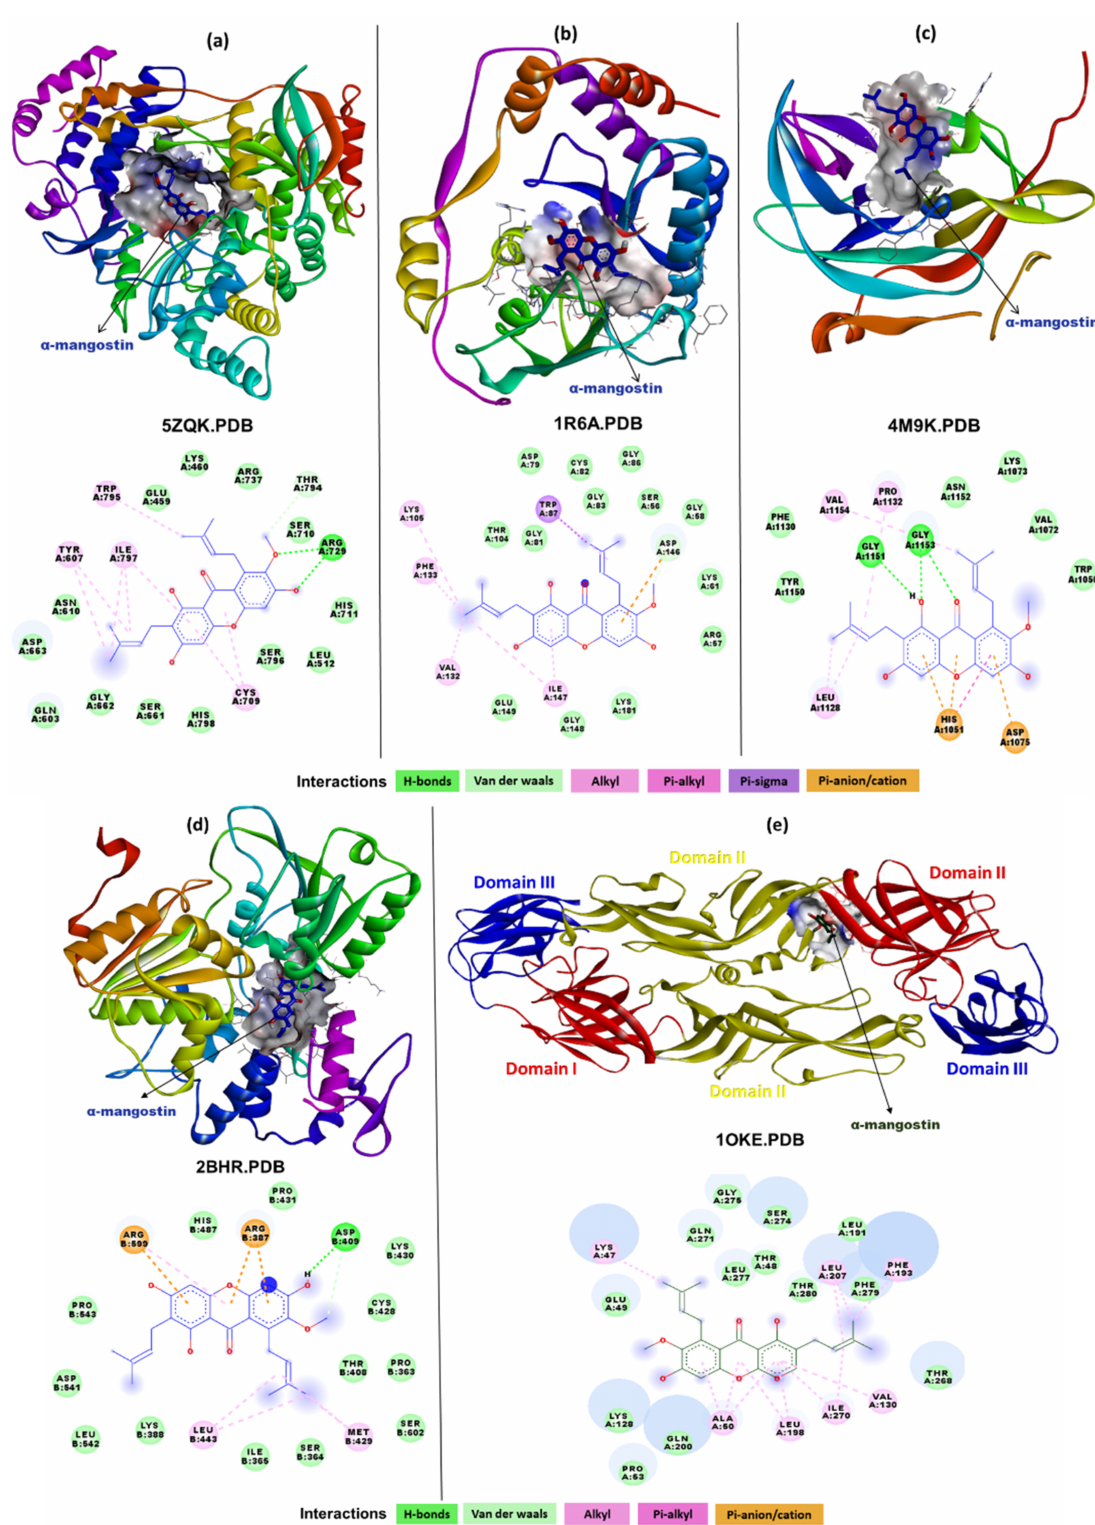
Figure 4. Molecular interactions of α -Mangostin with DENV non-structural and structural protein targets. Ribbon diagram with the solvent surface rendered view (probe radius 1.6 Å) and 2-dimensional interaction diagram showing α -Mangostin (in blue stick model) interaction with DENV ( a ) NS5 RdRP domain ( b ) NS5 methyltransferase domain ( c ) NS2-NS3 protease domain ( d ) NS3 helicase domain. ( e ) Envelope glycoprotein complex. The different types of interactions are represented by different colors mentioned in the interactions color panel. The interactions were visualized and analyzed using Biovia Discovery studio client